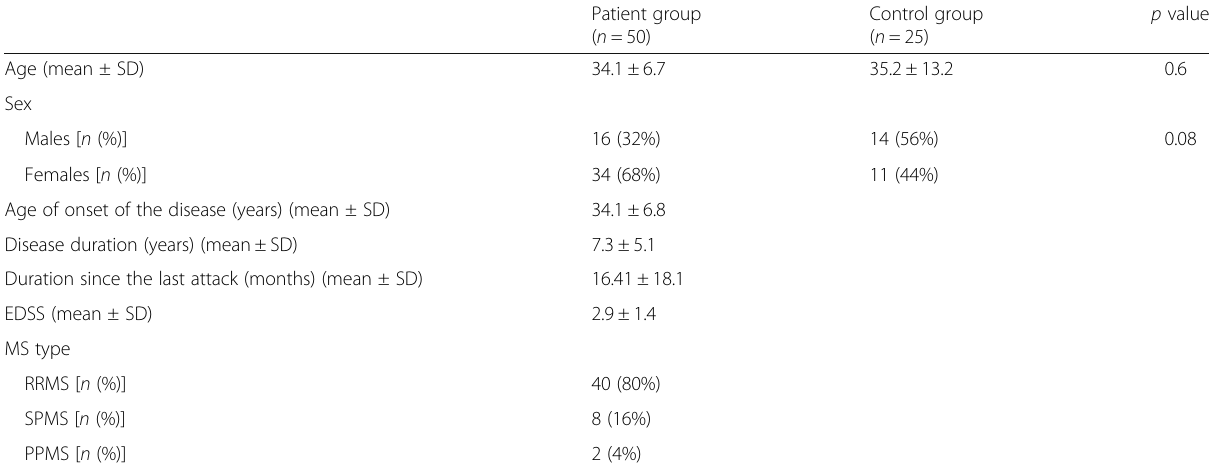
Table 1 Demographic characteristics of both groups